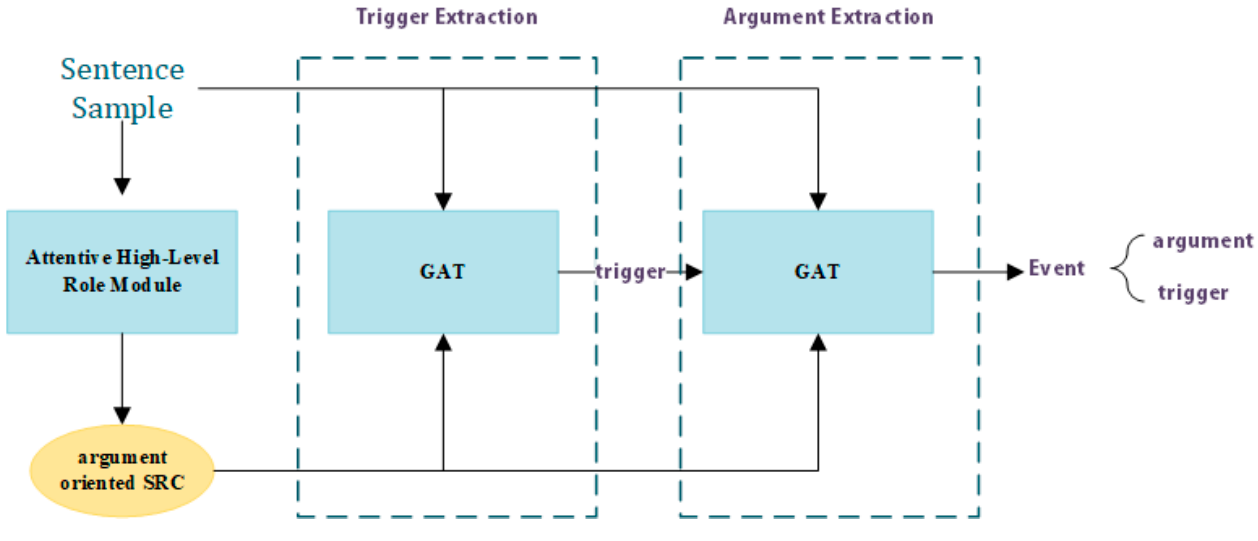
Figure 1. The process of movie scene event extraction.